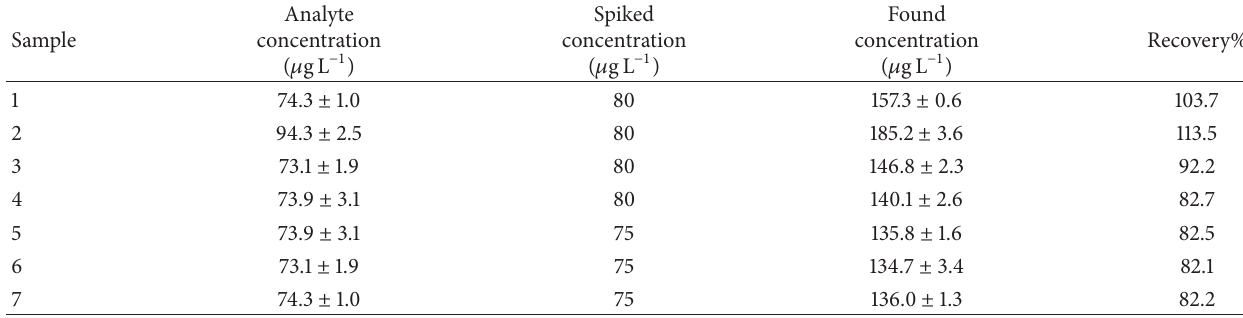
Table 4: Results of spiked recovery